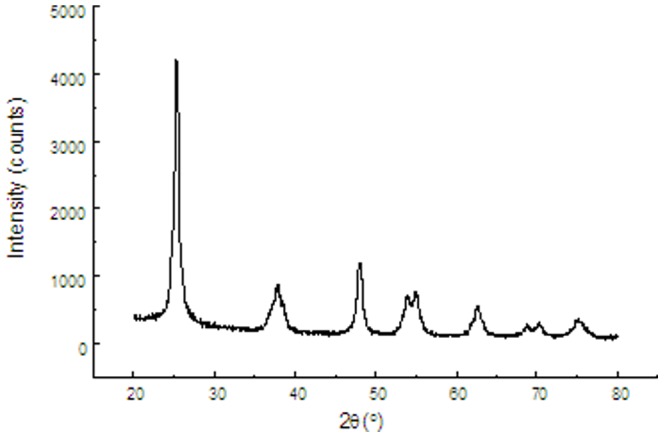
The (101) X-ray diffraction peak of anatase TiO2 NPs.